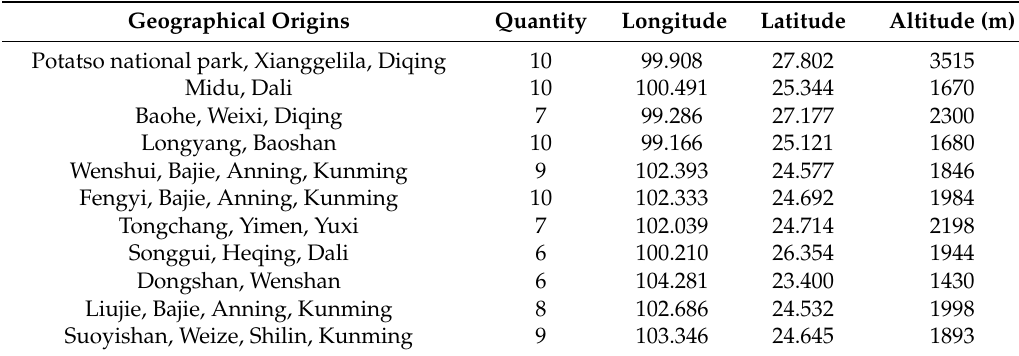
Table 1. Information of B. edulis